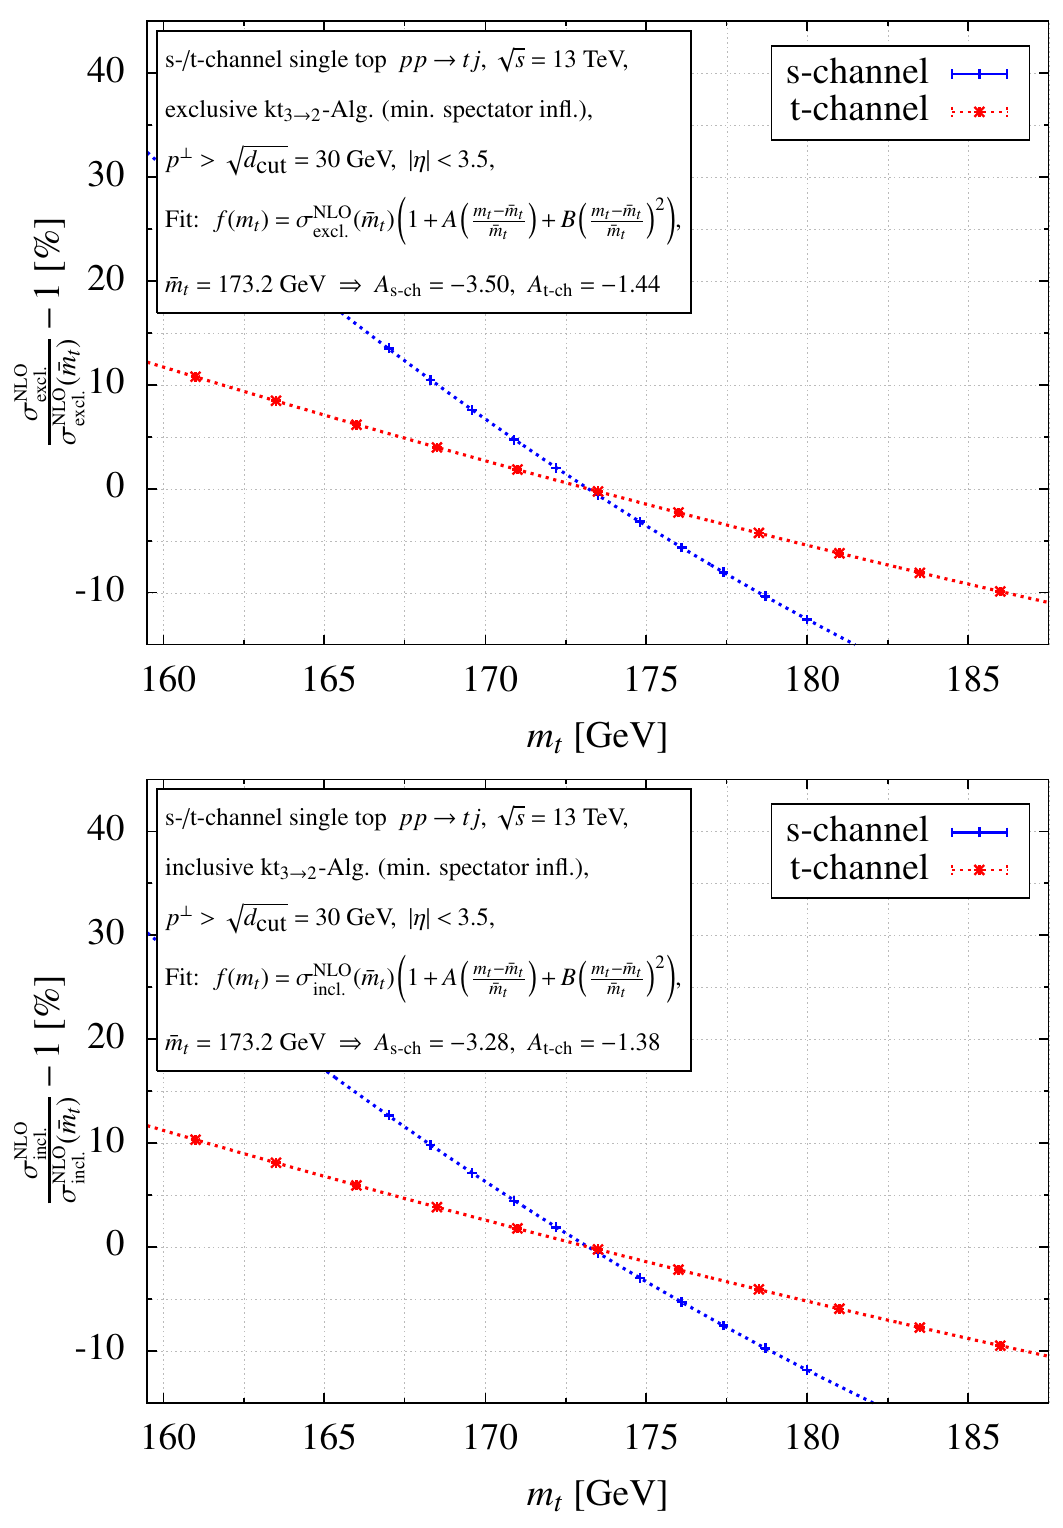
Figure 18 . Top-quark mass dependence of the (cid:12)ducial exclusive (top) and inclusive (bottom) s - and t -channel cross sections calculated at NLO accuracy.